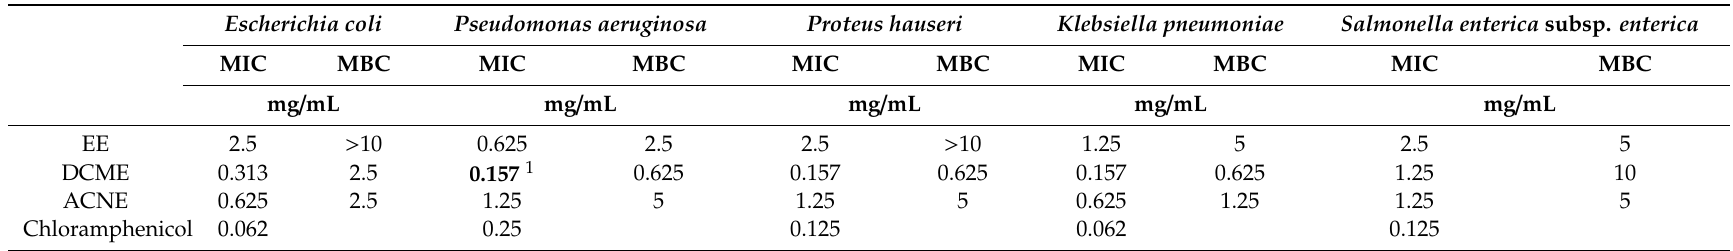
Table 3. Antibacterial activity of H. plicatum ethanol (EE), dichloromethane (DCME), and acetonitrile oil (ACNE) extract against Gram-negative bacteria.